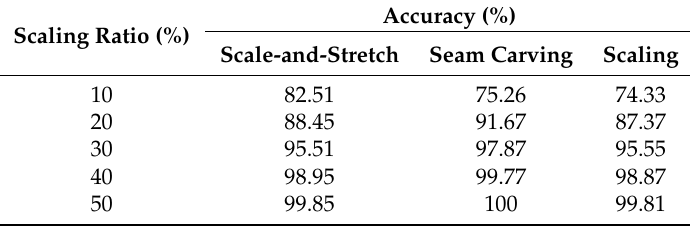
Table 1. Comparisons in terms of accuracy for tampered images with single re-targeting